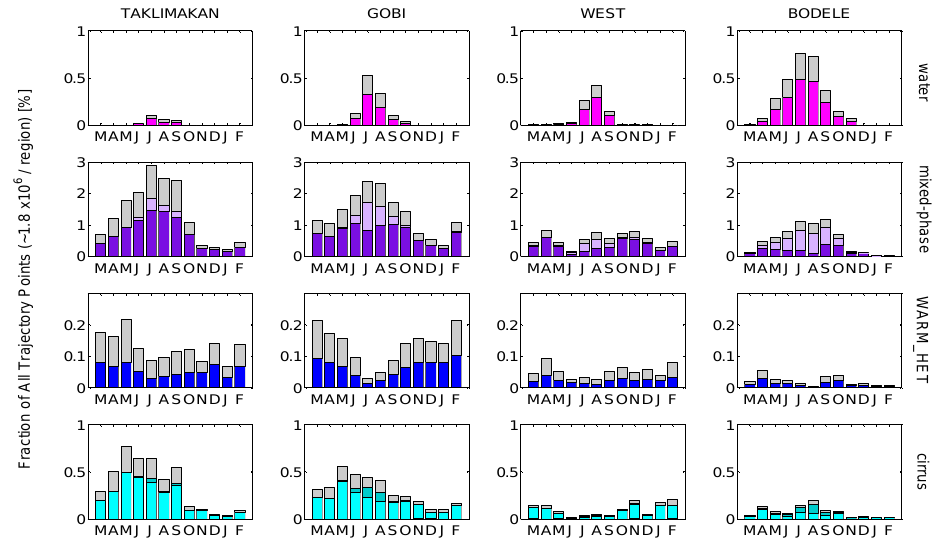
Fig. 6. Monthly breakdown of cloudy trajectory points in each geographic region (by column) and by cloud type (by row, as labelled, with details of cloud sub-types identified by color as in Fig. 5). COLD HET clouds are not